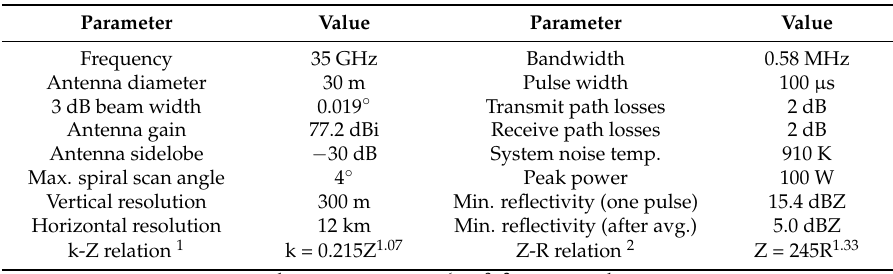
Table 1. GSWR radar parameters.